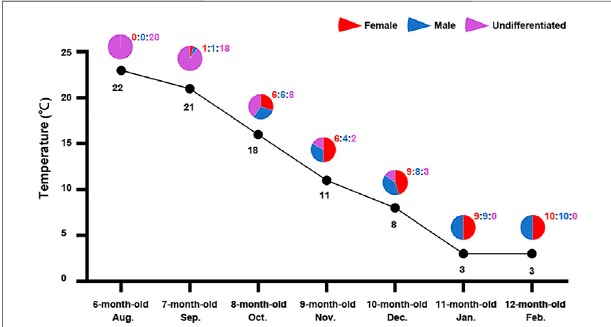
FIGURE 1 | Sex differentiation ratio of 6 – 12 month-old scallops and the corresponding seawater temperature in each month. For each month, 12 – 20 individuals were examined. The pie charts show the percentages of female (red), male (blue) and undifferentiated samples (purple) in each month. The values above the pie charts are the corresponding numbers of female (red), male (blue) and undifferentiated samples (purple). The line indicates the seawater temperatures for each